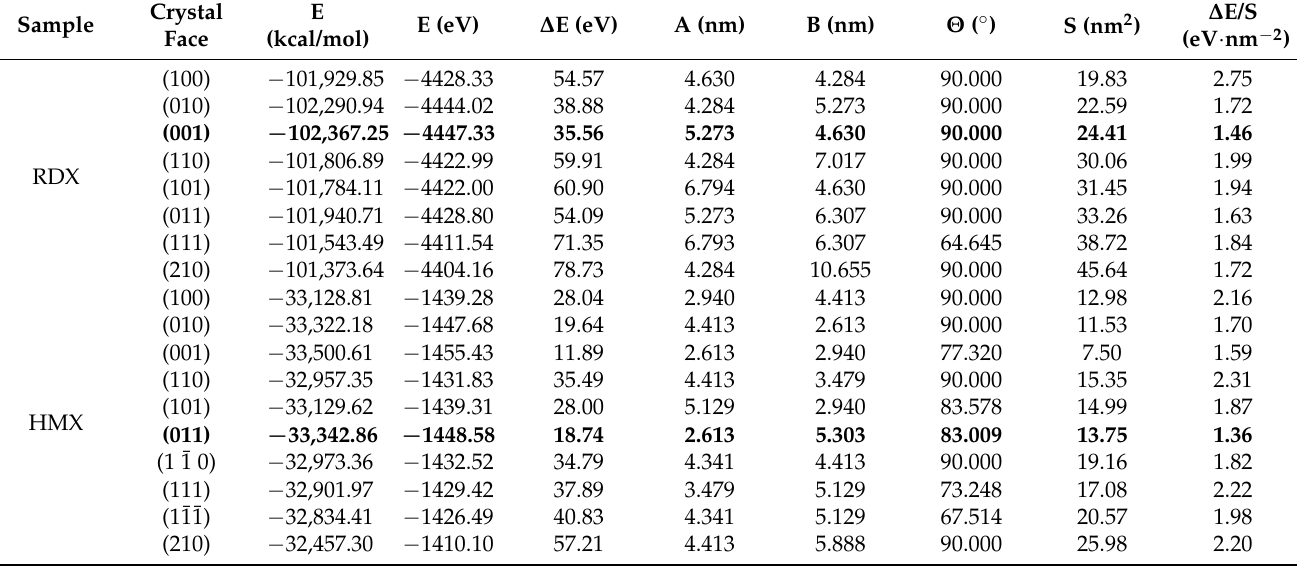
Table 1. The binding energies of RDX and HMX single crystals along different crystal